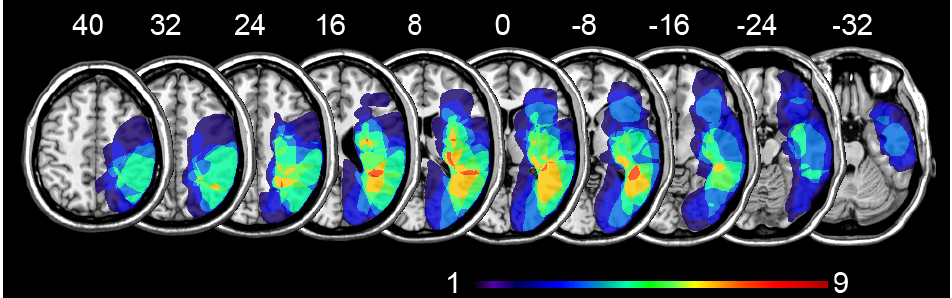
Figure 1. Lesion overlap plots for 12 out of 13 USN patients. Lesions were firstly drawn from CT scans in MRIcron software [45] and subsequently normalized using SPM with clinical toolbox [46]. Brain areas were labeled using the AAL template [47]. MRI axial slices were displayed according to the neurological convention. For each slice, the frequency of lesioned areas is represented through an NIH color scale ranging from 1 to 9 and superimposed on an MNI representative brain template using MRIcron. The procedure of lesion mapping is identical to those already published [48].